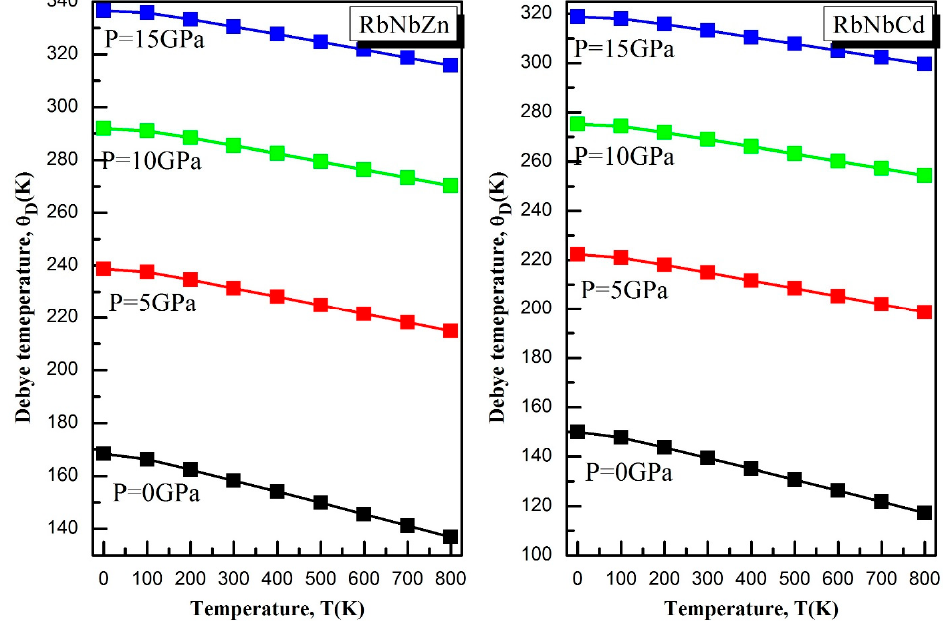
Figure 9. Debye temperature ( θ D ) as a function of temperature at different pressures for RbNbCd and RbNbZn.